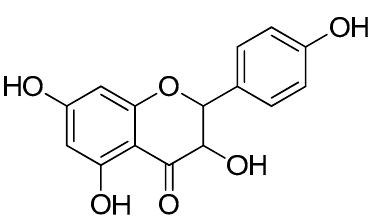
Figure 1. The chemical structure of aromadendrin.